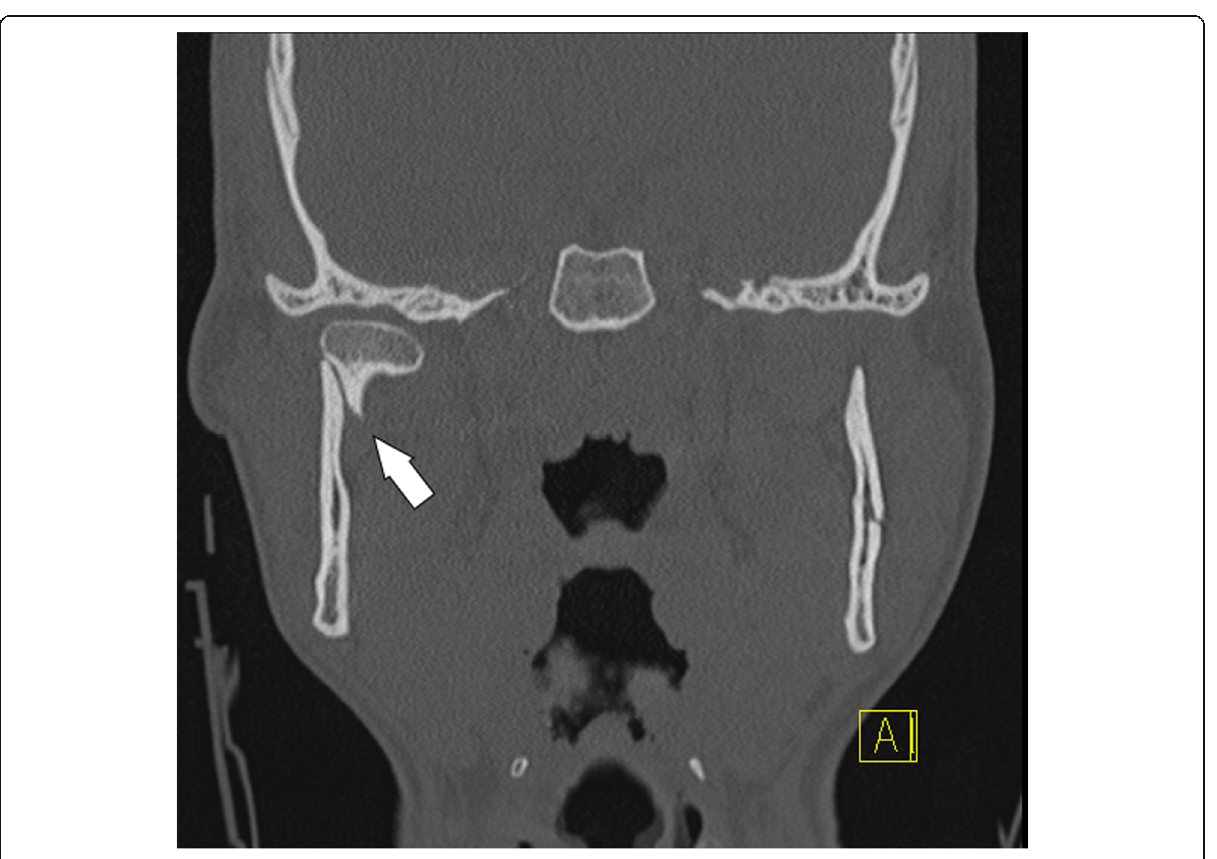
Fig. 15 Condylar process fracture. Deviation. Computed tomography coronal section shows that the condylar head remains within the glenoid fossa and the contact between the bone fragments is not completely lost